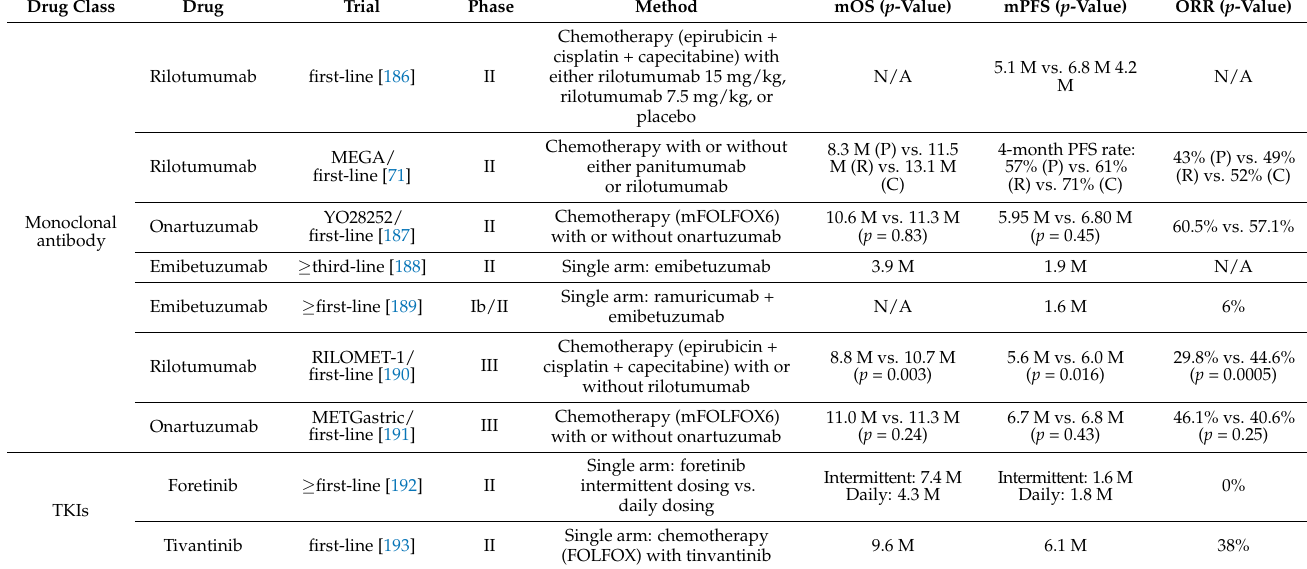
Table 6. Phase II and III trials of therapies targeting hepatocyte growth factor receptor-1. mOS, median overall survival; mPFS, median progression-free survival; HR, hazard ratio; M, months;